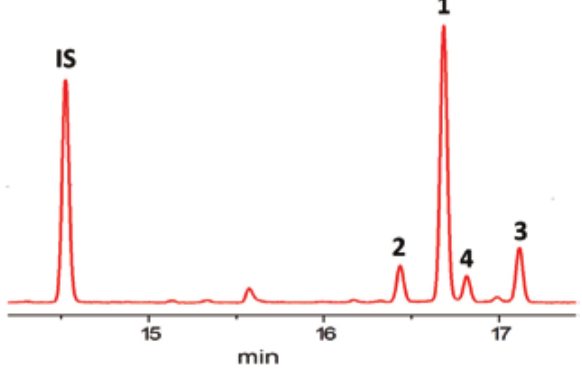
Figure 2. GC-FID chromatogram of four HP isomers obtained by photooxygenation of α-pinene: Cumene-hydroperoxide ( IS , 14.5 min), 4-hydroperoxy-4,6,6-trimethylbicyclo[3.1.1]hept-2-ene ( 2 , 16.4 min), pinocarvyl-hydroperoxide ( 1 , 16.7 min), verbenyl-hy- droperoxide ( 4 , 16.8 min) and myrtenyl-hydroperoxide ( 3 , 17.1 min). Retention times are given in parentheses.